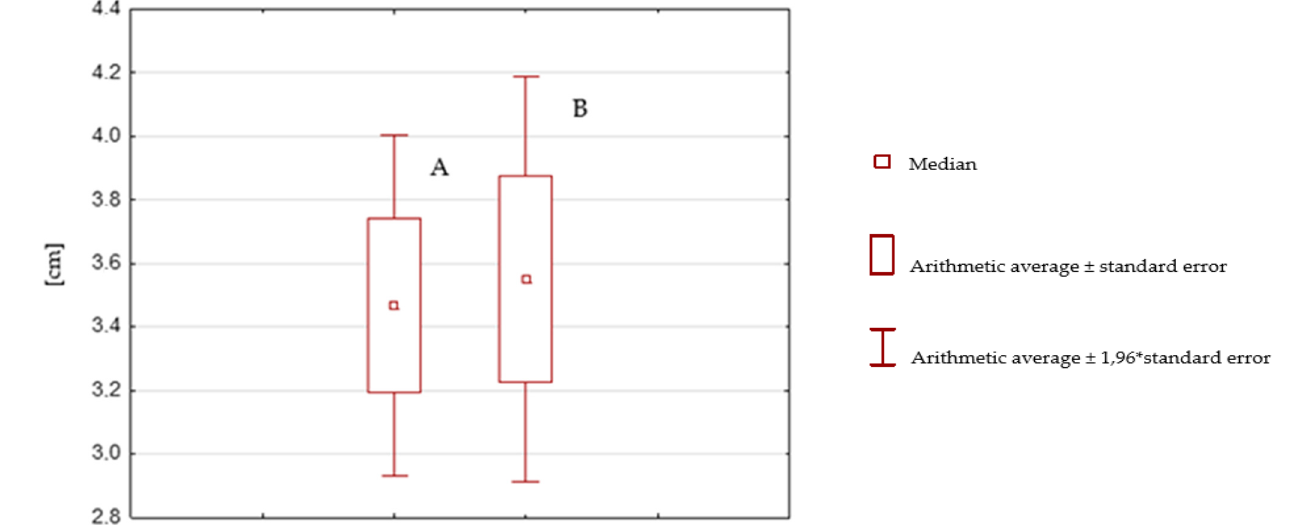
Figure 8. Box plot after rehabilitation without SPIDER system (A) versus before rehabilitation without SPIDER system (B).